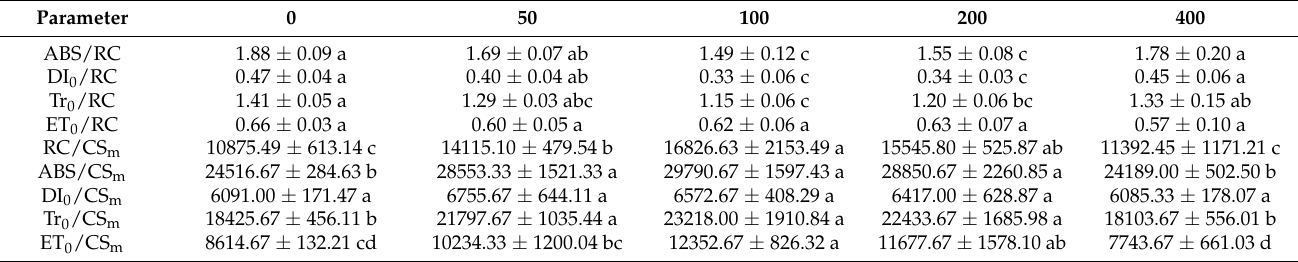
MT: melatonin. Data are means ± standard error; different letters indicate significant differences as determined by the Duncan test ( p ≤